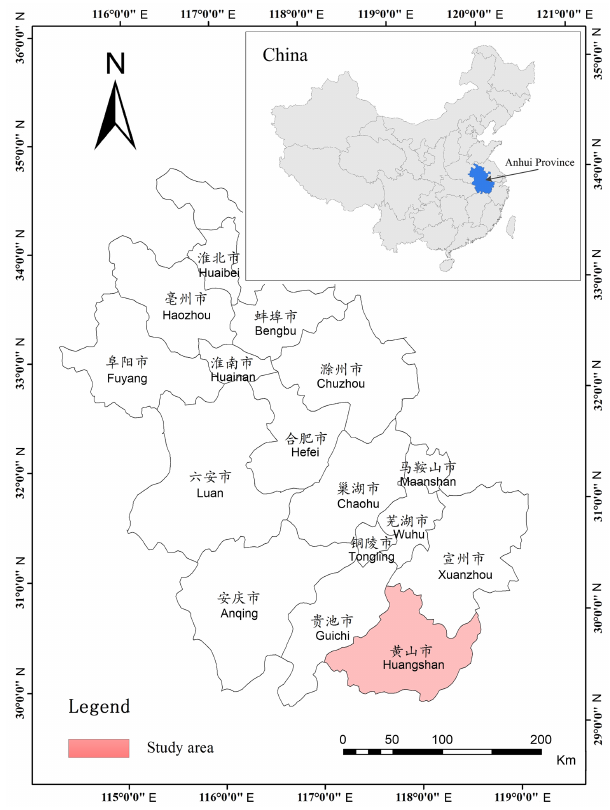
Figure 1. Location of the Huangshan region. The inset map shows the location of the province of Anhui,